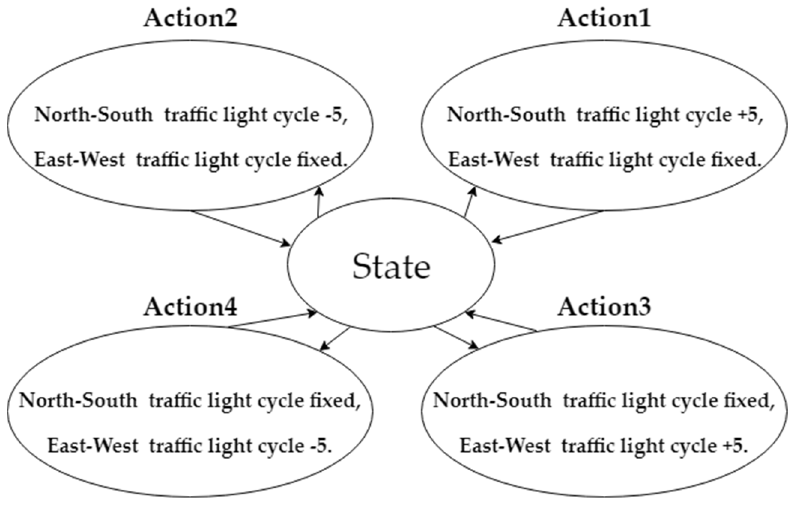
Figure 9. State transition diagram with four actions.